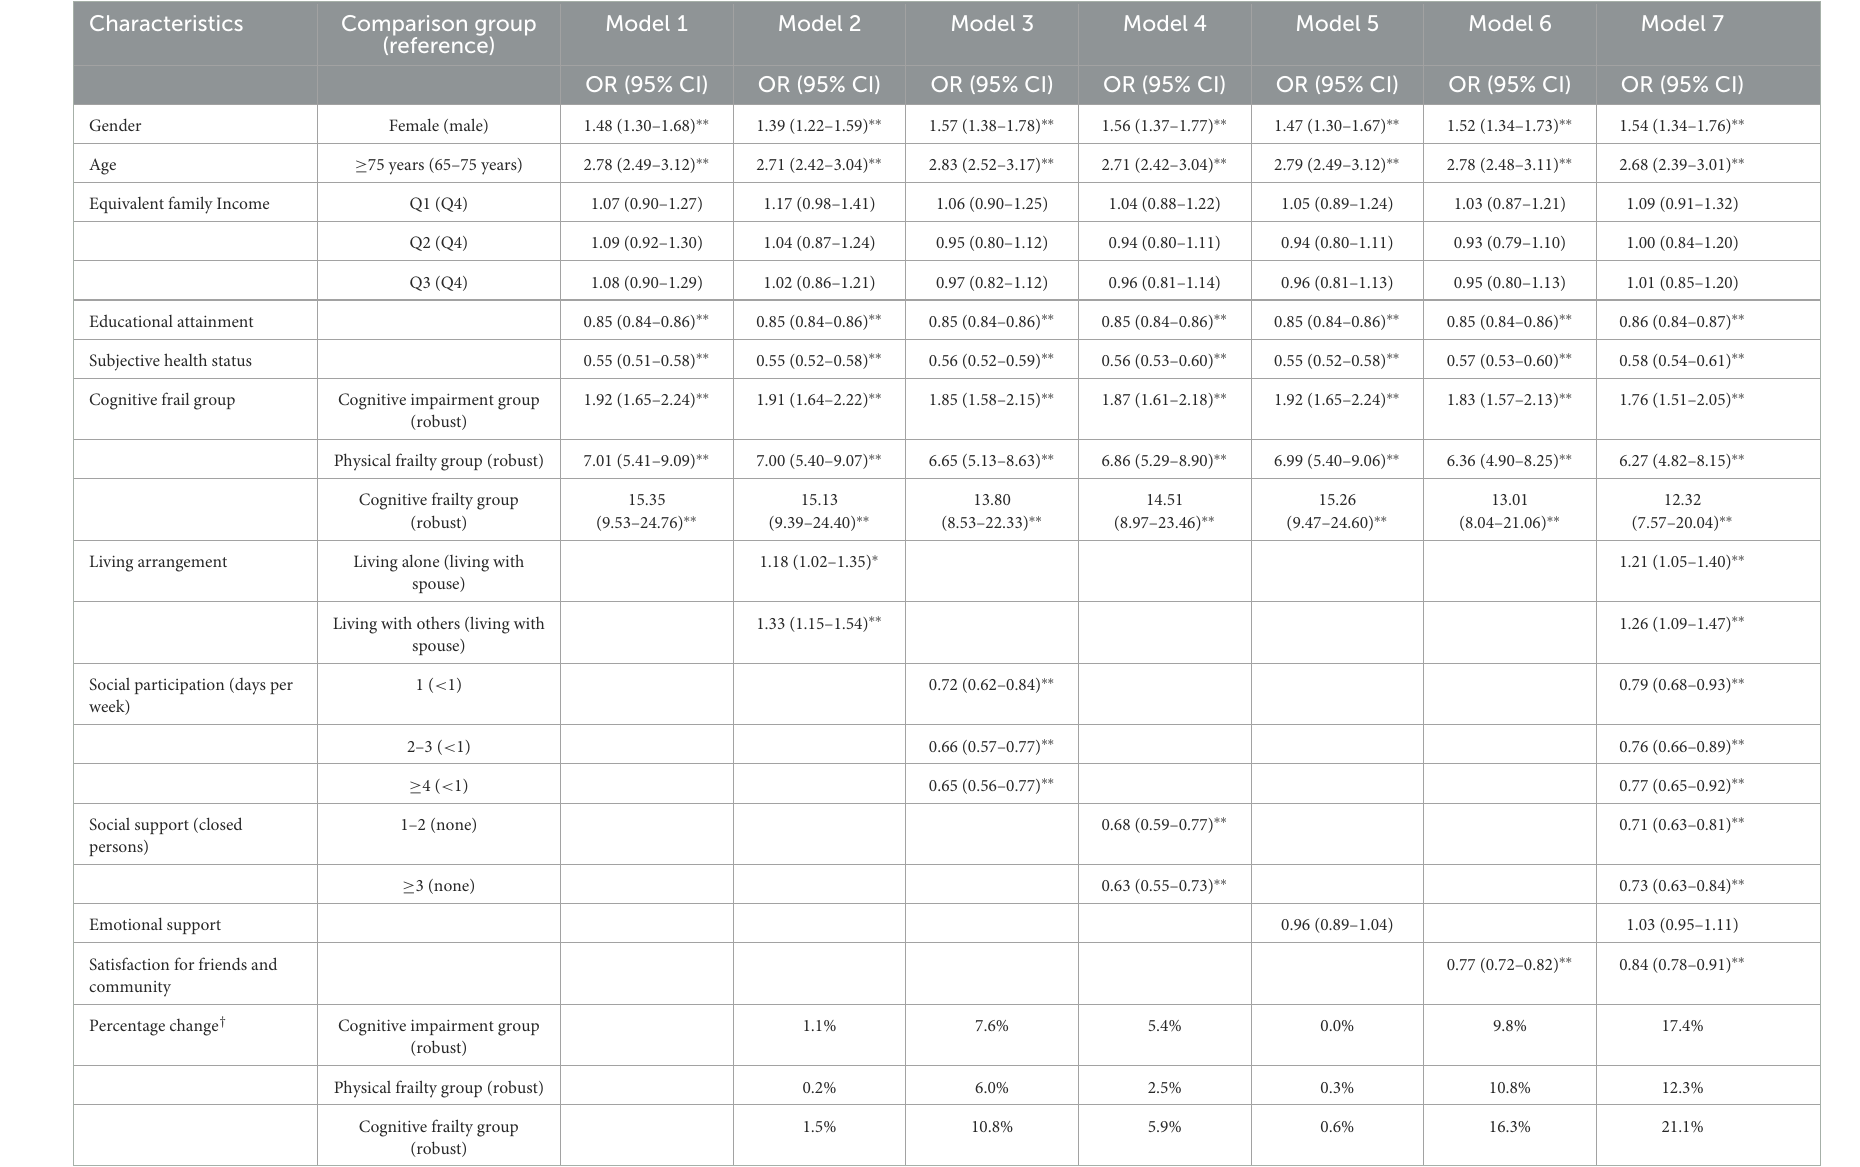
TABLE 2 Odds ratio and 95% confidence intervals (CI) for disability among Korean older persons aged 65 or